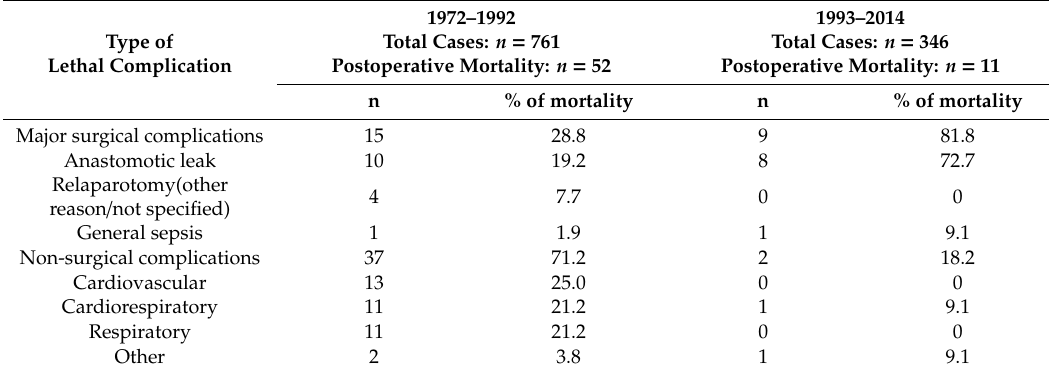
Table 4. Mortality-associated